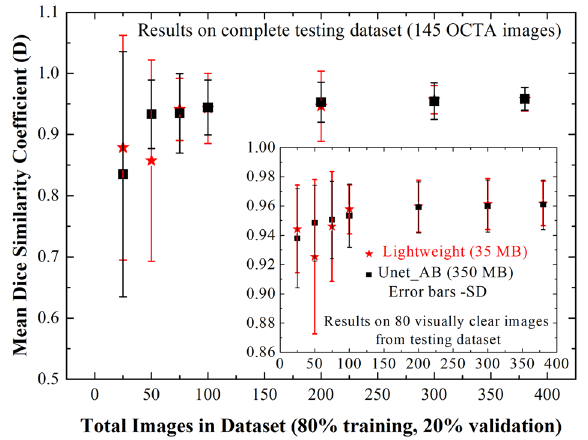
Figure 6. Effect of training dataset size on segmentation accuracy of FAZ by lightweight model (LWBNA_ Unet) developed in the present study, and Unet with attention block (Unet_AB). Mean D is obtained for the testing dataset of 145 OCTA images. Inset shows the results for 80 visually clear images selected from the testing dataset. The error bars correspond to standard deviation (SD) in D.